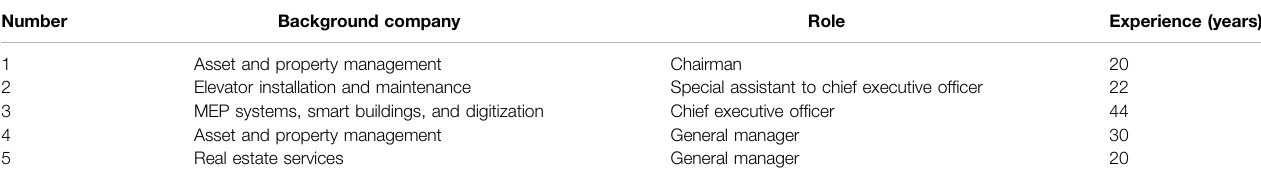
TABLE 2 | Pro fi le of experts.